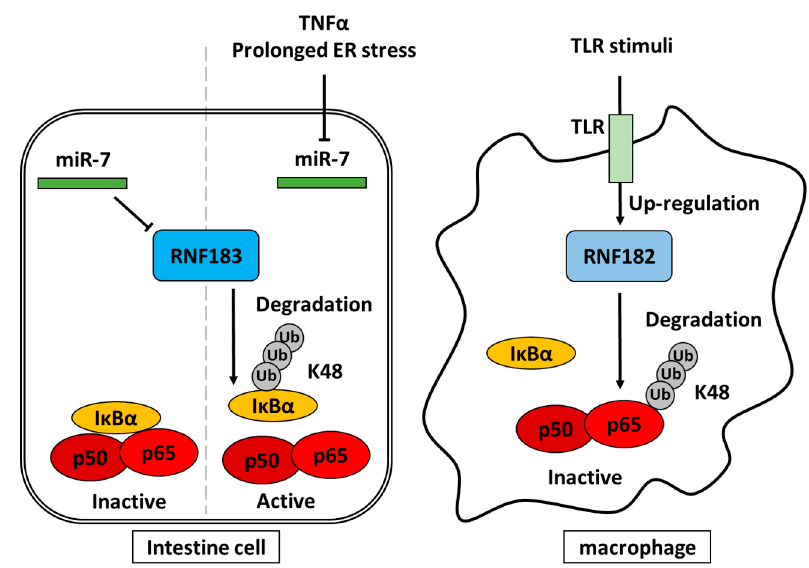
Figure 3. RNF183 and RNF182 are involved in the regulation of the NF- κ B pathway. First, RNF183 ubiquitylates I κ B α . Then, the ubiquitylated I κ B α is degraded, and next, the NF- κ B pathway is activated. The miR-7 suppresses the transcription of RNF183. TNF α and prolonged ER stress decrease miR-7, resulting in an increased expression of RNF183. RNF182 ubiquitylates and degrades the subunit p65 of NF- κ B, and the TLR stimuli induces the expression of RNF182. Both I κ B α and the subunit p65 of NF- κ B are ubiquitylated with K48 chain. The arrows indicate activation and the T-bars indicate inhibition.